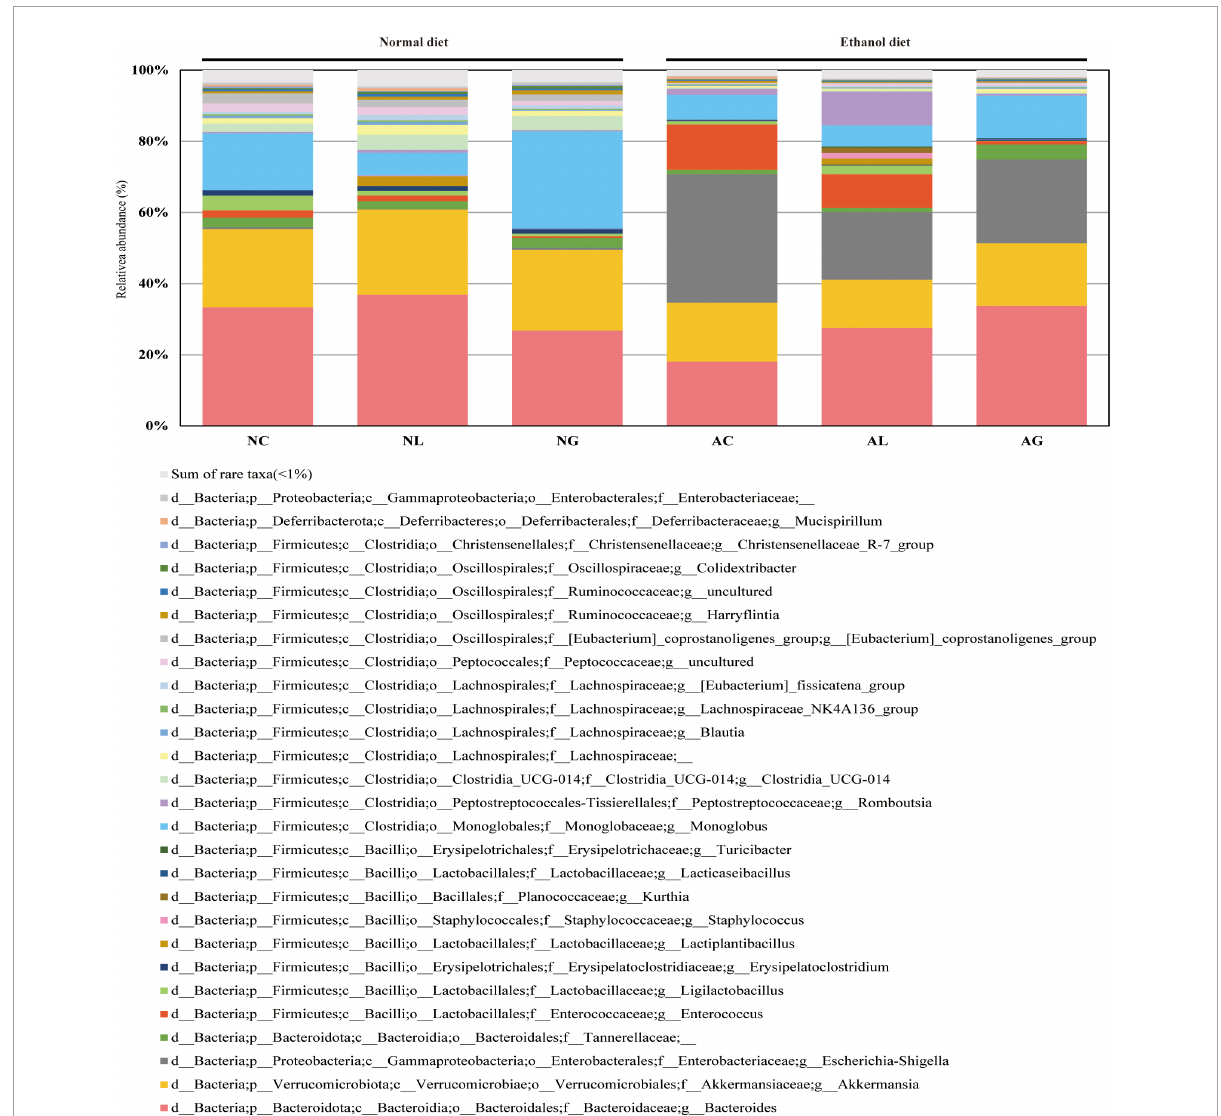
FIGURE5 Effect of administering kimchi-derived LAB on the relative abundance of gut microbiota in normal and alcohol diet-fed mice. The relative bacterial mean abundance at the genus level was calculated taking into consideration the mean value of the relative phylotypic compositions of respective fecal samples. The sum of rare taxa consisted of genera showing percentage of reads < 0.5% considering the total reads from all